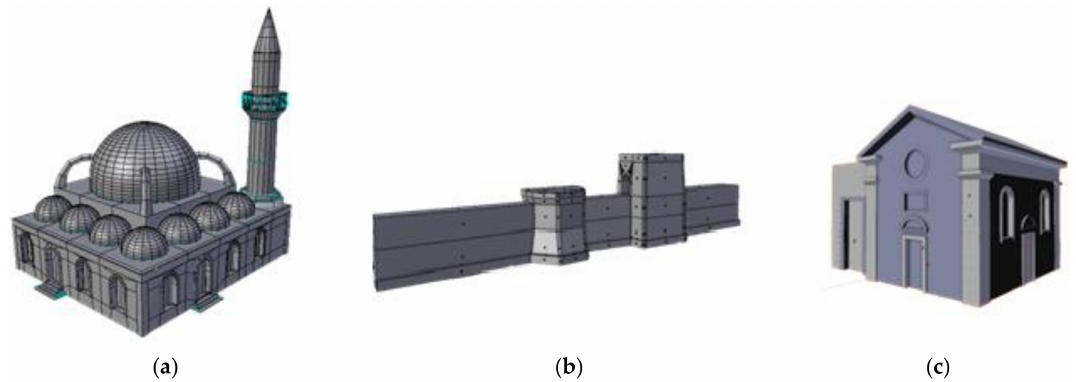
Figure 6. The final 3D meshes: ( a ) Glass Mosque; ( b ) Byzantine wall; ( c ) Saint Rocco temple